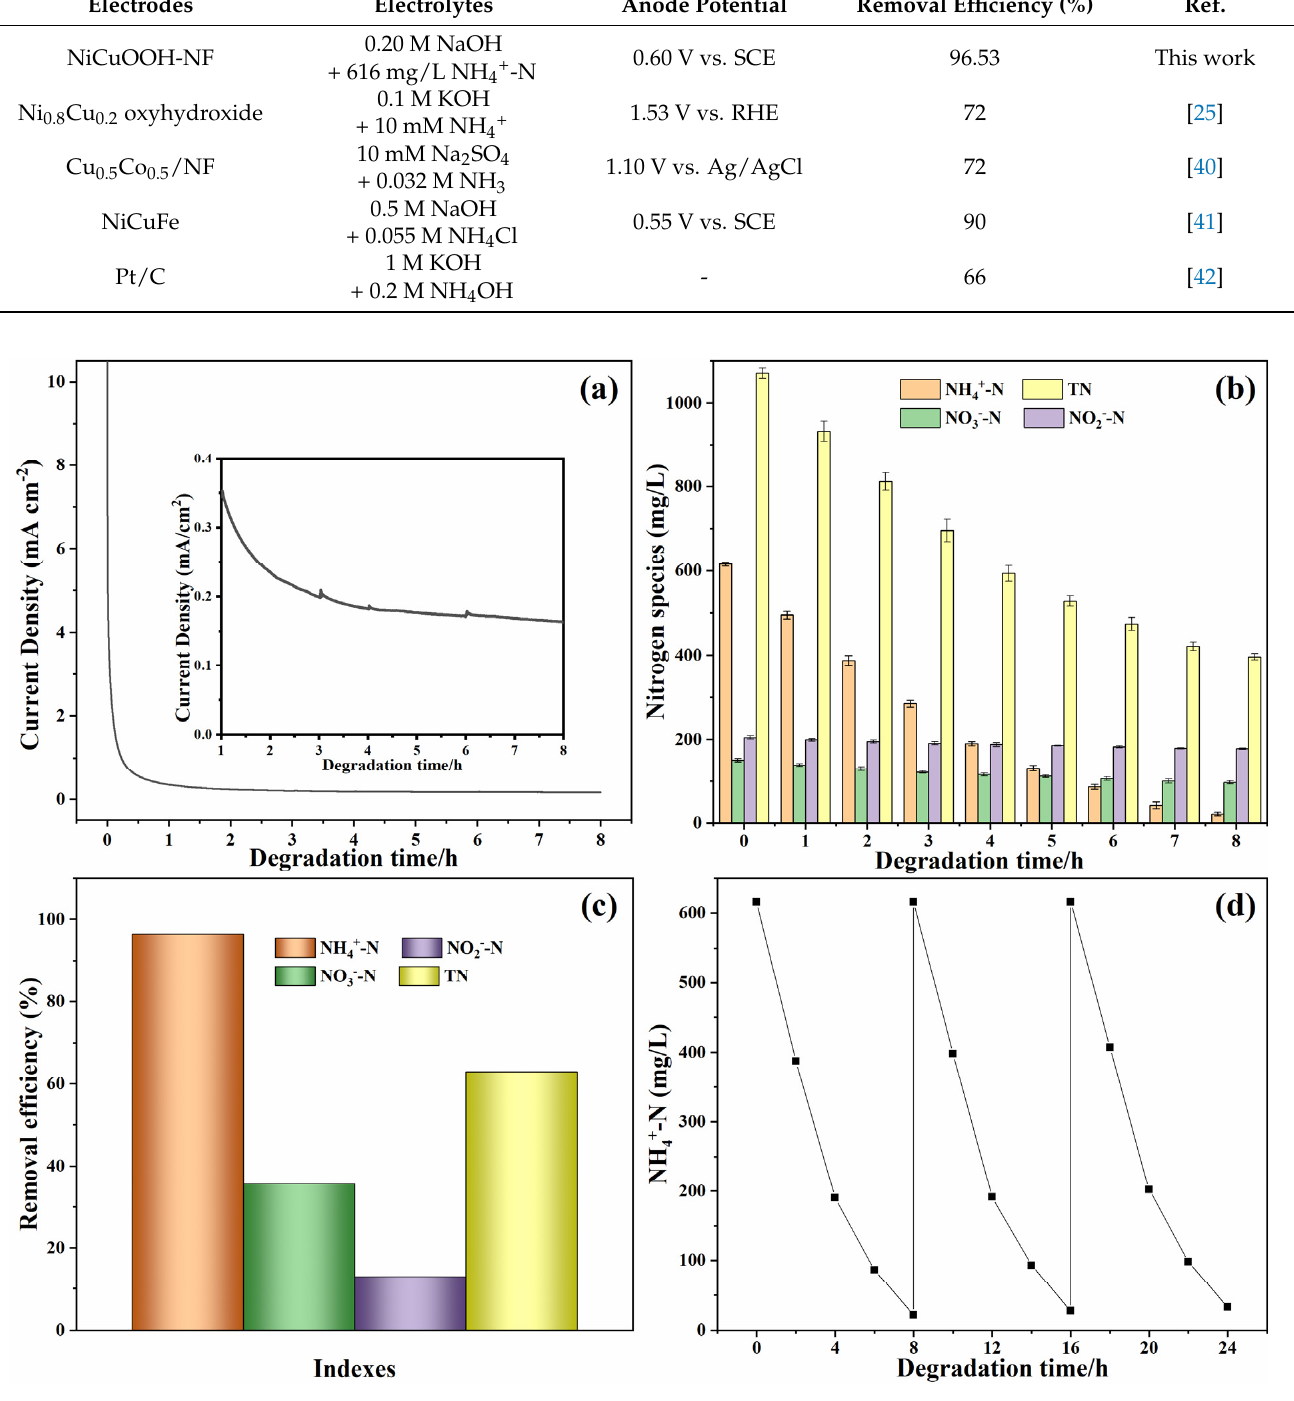
Figure 9. ( a ) Variation curves of the current density with degradation time, collected on NiCuOOH ‐ NF electrode; ( b ) Changes of nitrogen species concentration with degradation time; ( c ) Removal efficiency of nitrogen species; ( d ) Changes in NH 4+ ‐ N concentration before and after multi ‐ cycle ammonia nitrogen removal.